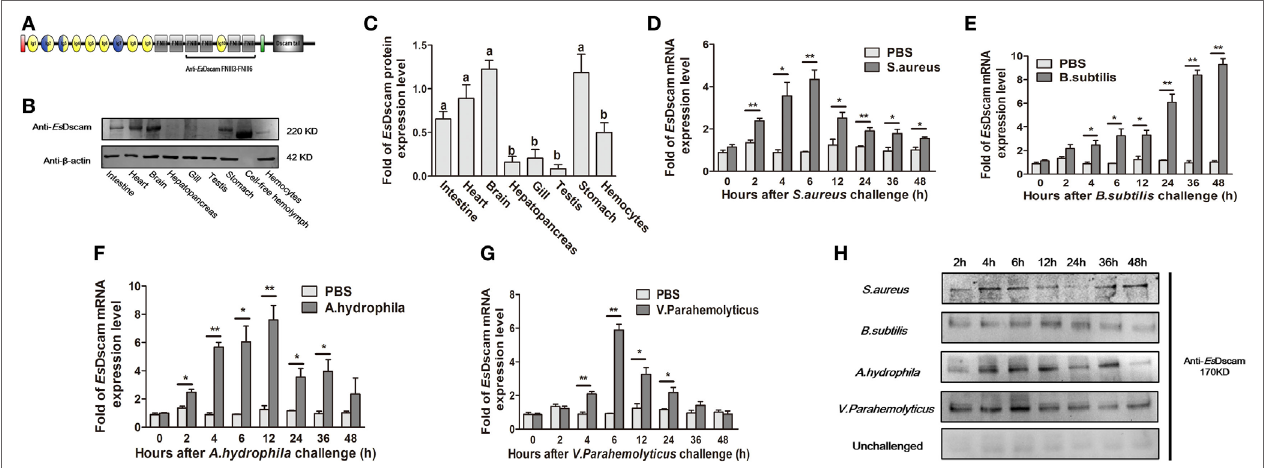
FigUre 2 | Identification of Es Dscam as a bacteria-sensitive gene in crab hemocyte. (a) Schematic diagram of the conserved Es Dscam FNIII3–FNIII6 region recognized by the Es Dscam Ab. (B,c) Tissue distribution of Es Dscam. ( Left panel ) The protein expression was analyzed by Western blot with β -actin detected as the reference. Each sample was from four crab. ( Right panel ) ImageJ was used to scan the Western blot bands from three independent repeats. Relative expression level of Es Dscam/ β -actin are shown, and the value are expressed as relative arbitrary units. Results were analyzed by one-way ANOVA and the letters (a, b) presented significant differences ( p < 0.05). (D–g) Expression profile of Es Dscam mRNA after bacterial stimulation in the hemocytes. RNA was extracted at each time point from experimental and control crab. qRT-PCR was performed to examine the expression of Es Dscam in each sample with β -actin as the reference gene. The expression was normalized to that in PBS stimulated crab. Three independent repeats were performed with at least three crab for each sample, and results are expressed as the mean ± SD. Data were analyzed by Student’s t -test. * p < 0.05, ** p < 0.01. (h) Expression profile of soluble Es Dscam protein in hemocyte culture medium after bacterial stimulation. The protein expression was analyzed by Western blot with unchallenged hemocyte as the control. Data are representative of two independent